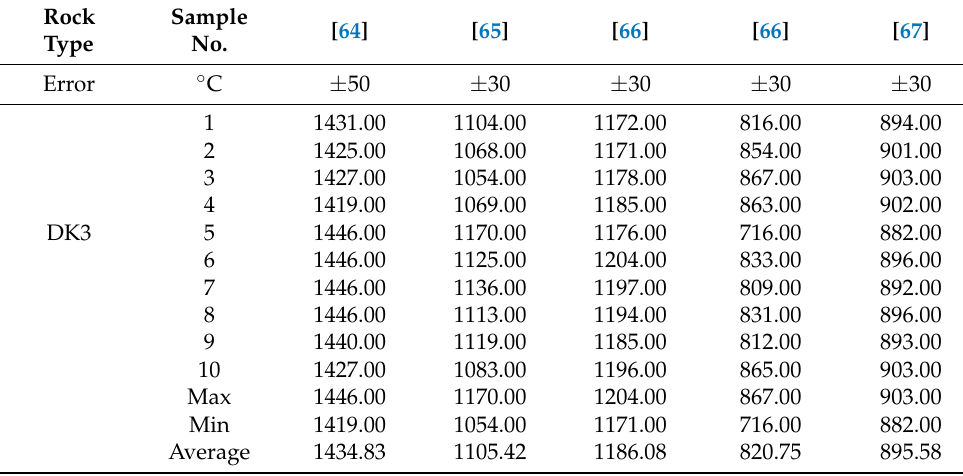
Table 8. Results of the geothermometry calculations for